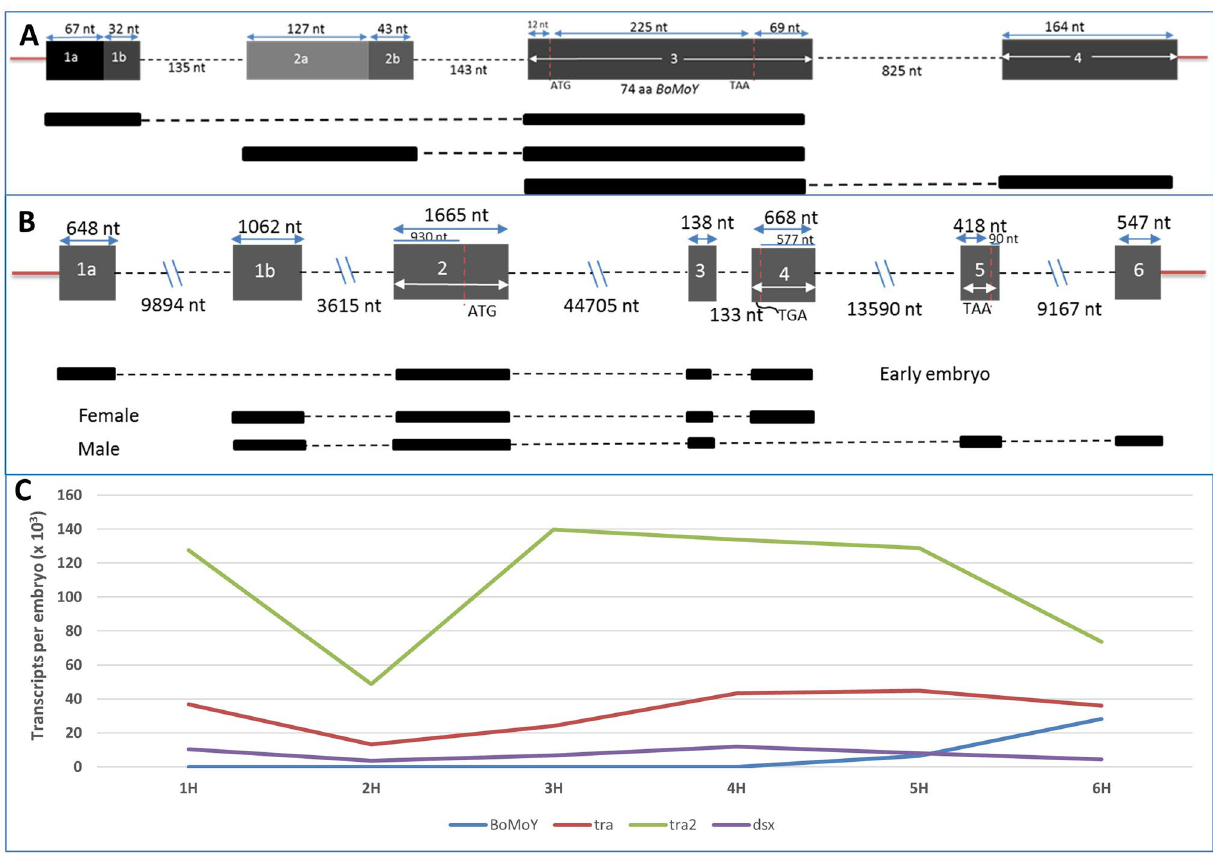
Figure 5. Schematic of the gene structure and expression profile of B. oleae sex-determining genes. ( A ) Bactrocera oleae maleness-on-Y ( BoMoY ) gene model and the 3 isoforms observed. ( B ) Double sex ( dsx ) gene model and the prominent isoforms observed in early embryo development as well as adult male and female. ( C ) Expression profile of BoMoY , transformer ( tra ), transformer2 ( tra2 ), and doublesex ( dsx ) shown as number of transcripts per embryo. The expression was calculated for total gene expression rather than sex-specific isoforms for tra and dsx which were below quantification